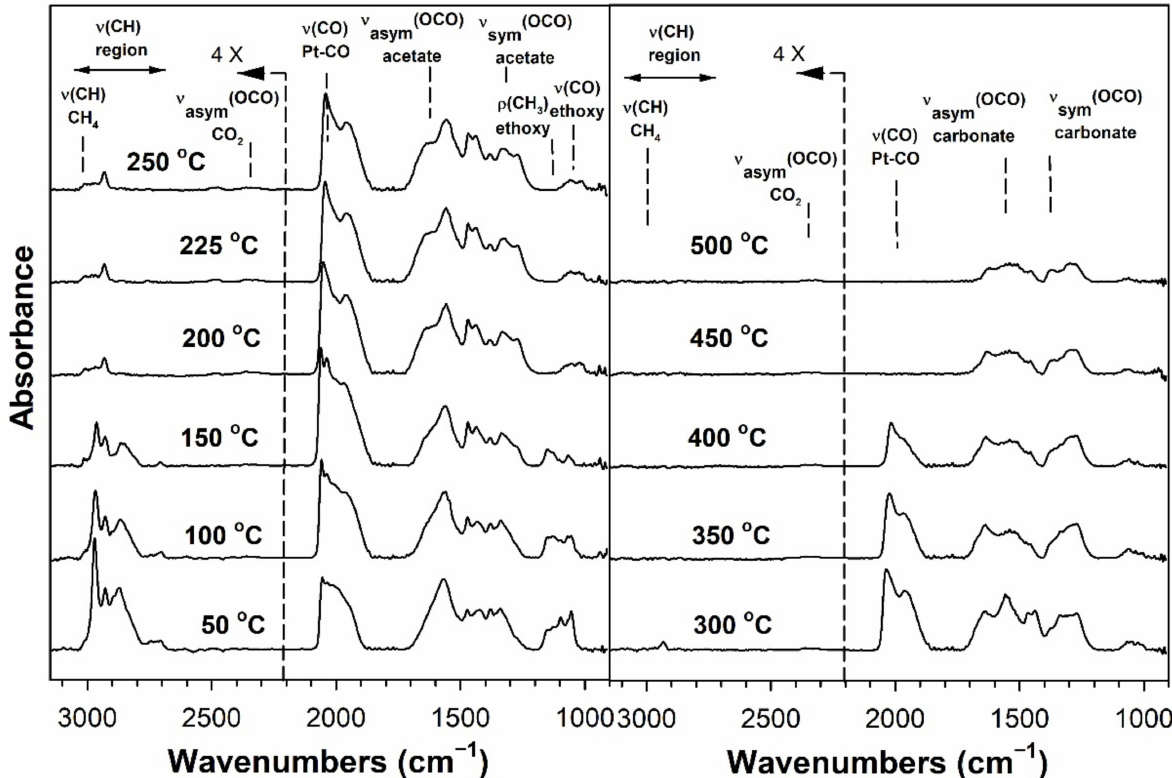
Figure 5. DRIFTS spectra of transient ESR over 0.85% K-2% Pt/m-ZrO 2 .